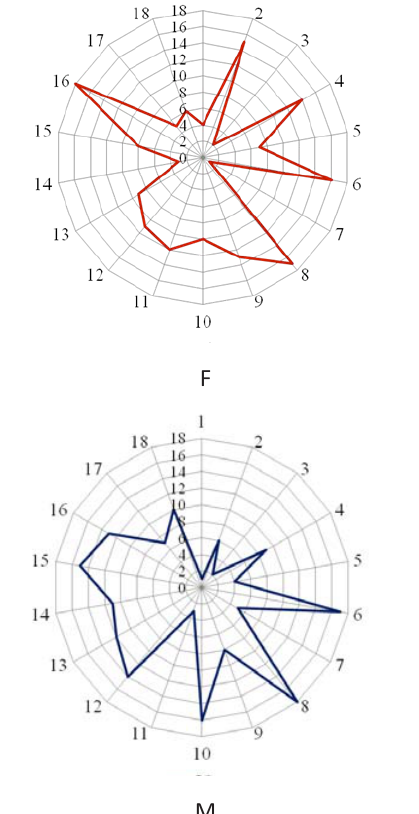
Fig. 2. Hierarchy of tool values of students (males, n=108; females, n=120):1 – accuracy; 2 – social training; 3 – high